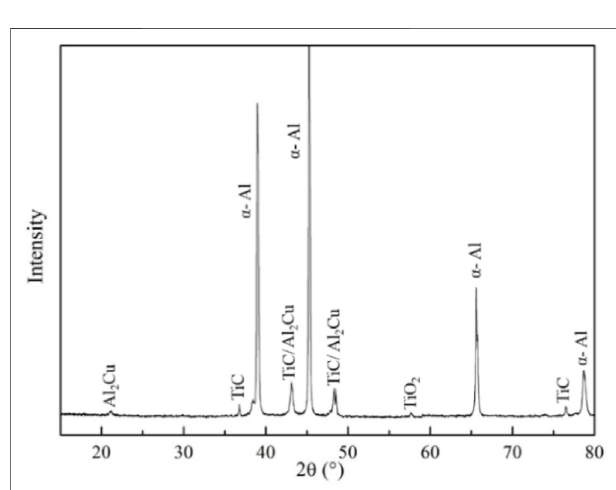
FIGURE 8 | XRD patterns of the TiC/2219 nanocomposite samples extracted from the center position.